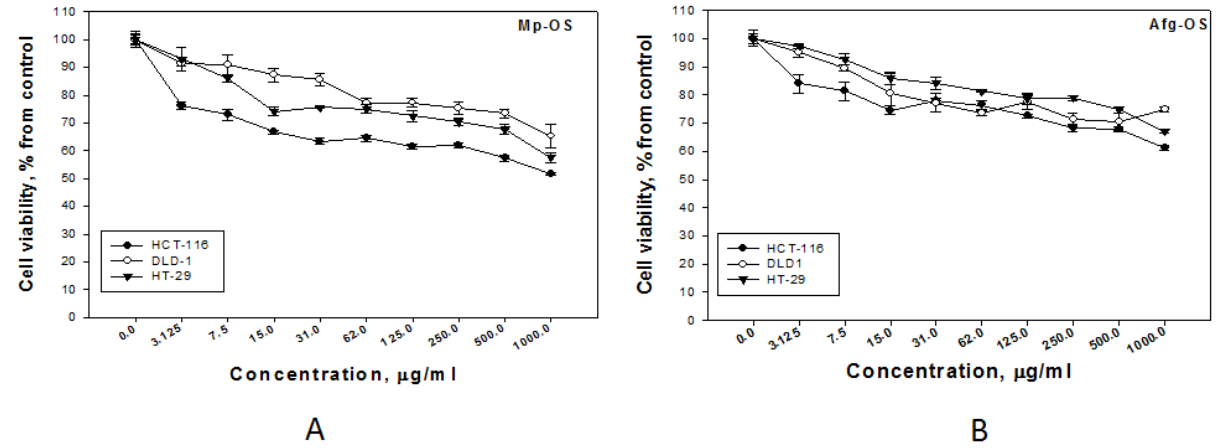
Figure 2. Antiproliferative effect of oligosaccharides Mp-OS ( A ) and Afg-OS ( B ) against three types of tumor cells (HCT-116, DLD-1, HT-29). Incubation time with cells—2 h.